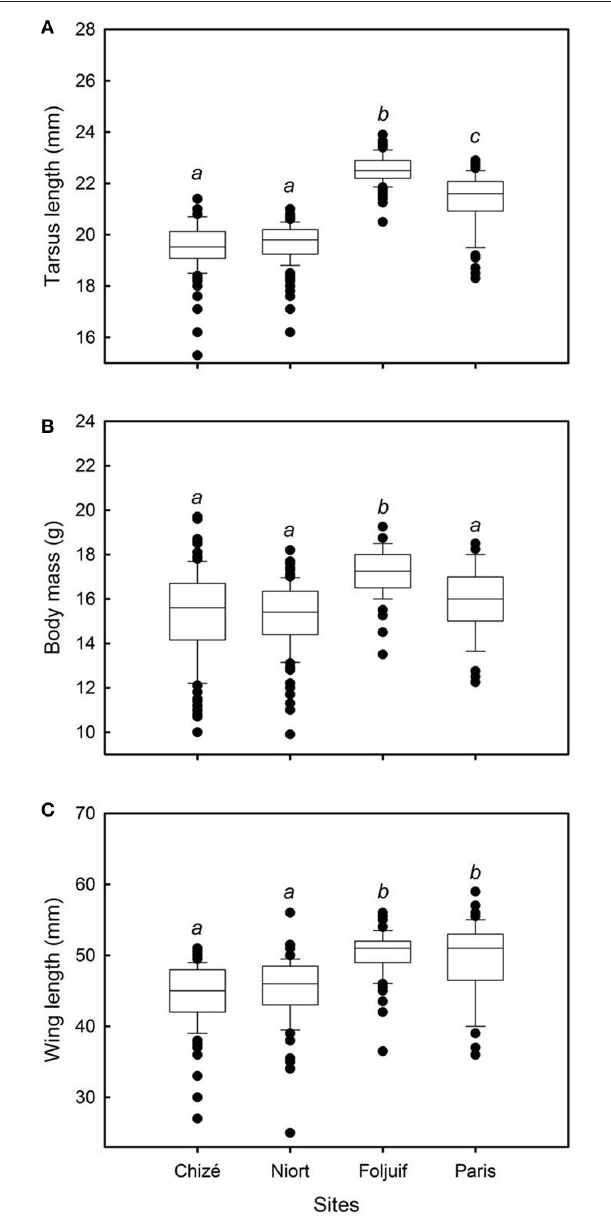
FIGURE 1 | Variation of (A) tarsus length, (B) body mass, and (C) wing length, among breeding sites in great tit nestlings. Nestling tarsus length was significantly greater in the rural site of Foljuif as compared to the other rural site of Chizé, and to both urban sites of Niort and Paris [differences of least squares means: t (df : 370) = 11.67, adj. p < 0.0001; t (df : 370) = 11.58, adj. p < 0.0001; and t (df : 370) = 4.38, adj. p < 0.0001, respectively]. Nestlings were also smaller in Chizé and Niort as compared to Paris [ t (df : 370) = − 6.20, adj. p < 0.0001; and t (df : 370) = − 5.95, adj. p < 0.0001, respectively]. Nestlings were significantly heavier in the rural site of Foljuif as compared to Chizé, Niort, and Paris [differences of least squares means: t (df : 370) = 3.56, adj. p = 0.002; t (df : 370) = 4.03, adj. p = 0.0004; and t (df : 370) = 2.54, adj. p = 0.05, respectively]. Wing length was significantly greater both in Foljuif and Paris as compared to Chizé [ t (df : 369) = 4.19, adj. p = 0.0002; and t (df : 369) = 3.18, adj. p = 0.01] and Niort [ t (df : 369) = 3.84, adj. p = 0.001; t (df : 369) = 2.82, adj. p = 0.03], respectively. Different letters indicate significant differences.